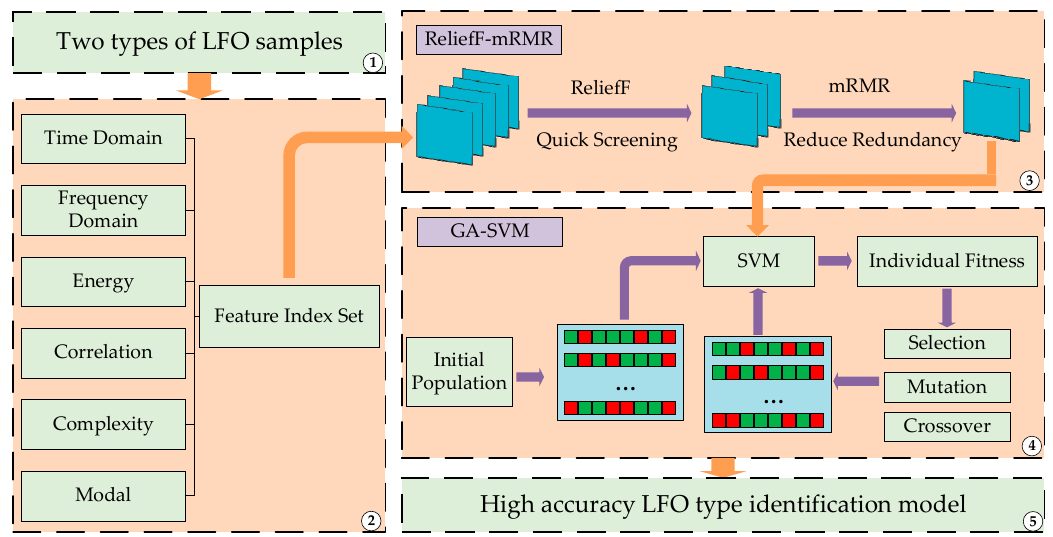
Figure 2. Schematic diagram of LFO type identification method based on multidimensional features and ReliefF-mRMR.